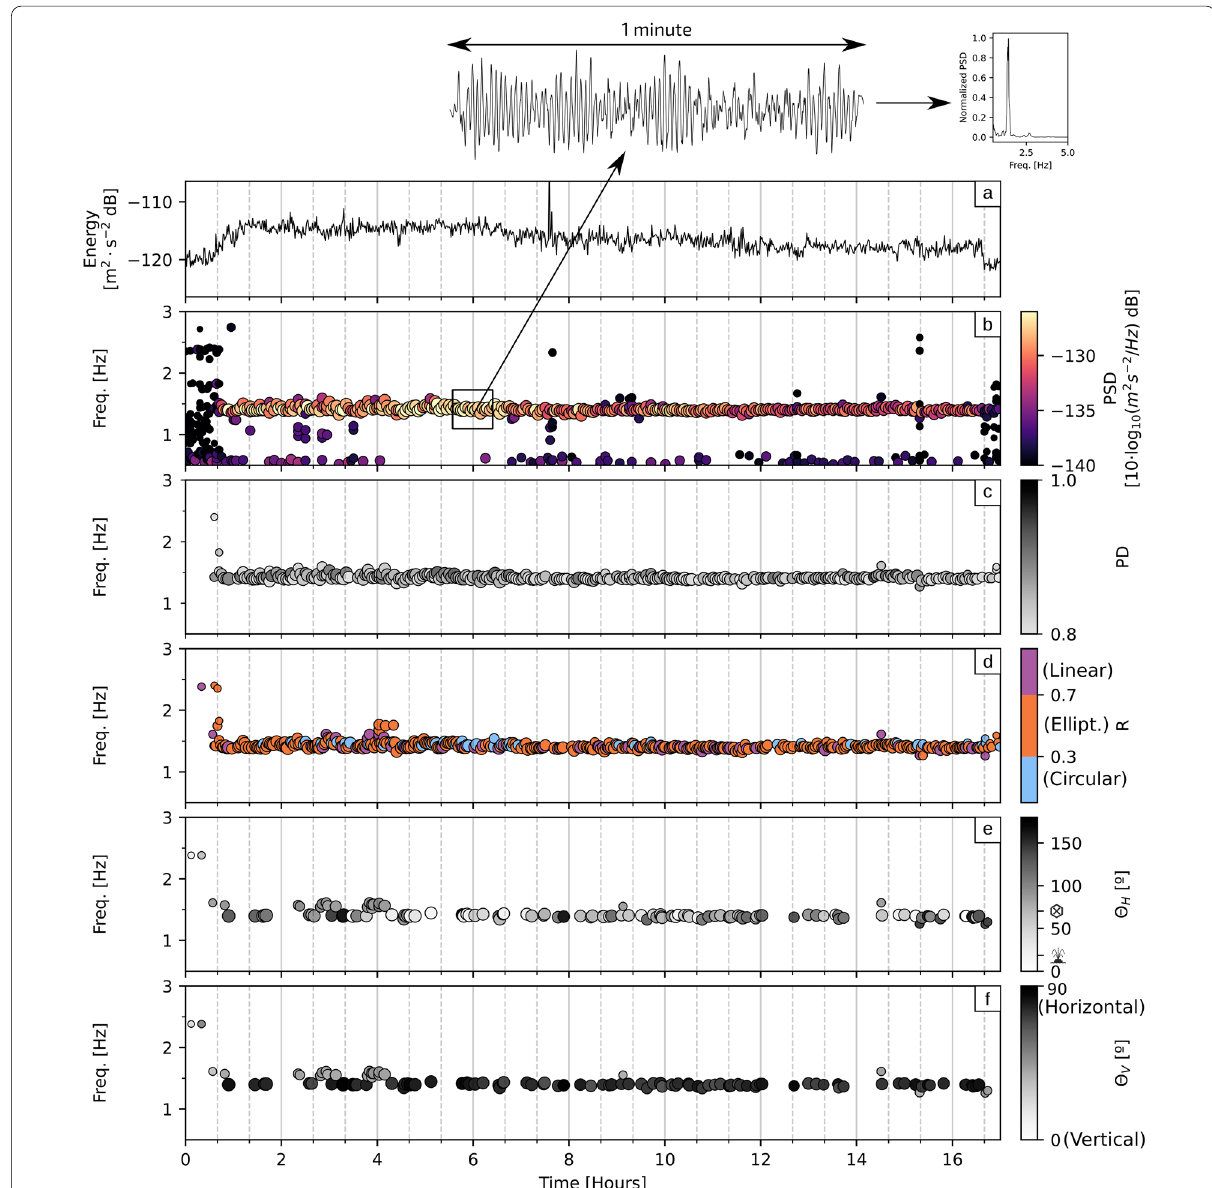
Fig. 2 Time evolution of reduced parameters for the NB episode occurred at 23:40:00 UTC on 21 July 2019. a Energy in the range 0.5–10 Hz. b Spectral peaks with energy above 95% of the maximum, i.e., samples. c Averaged polarization degree (PD) of each sample in the range when PD (cid:31) 0.8 and σ PD (cid:31) 0.1 . d Averaged rectilinearity ( R ) of each sample in the range ( (cid:31) H ) and f vertical incidence ( (cid:31) V ) of each sample when R (cid:31) 0.7 and σ H , σ V (cid:31) 5 ◦ . Due to the large number of samples, only the third part of the information is depicted in b and c . The size of each circle is proportional to its spectral energy, given in